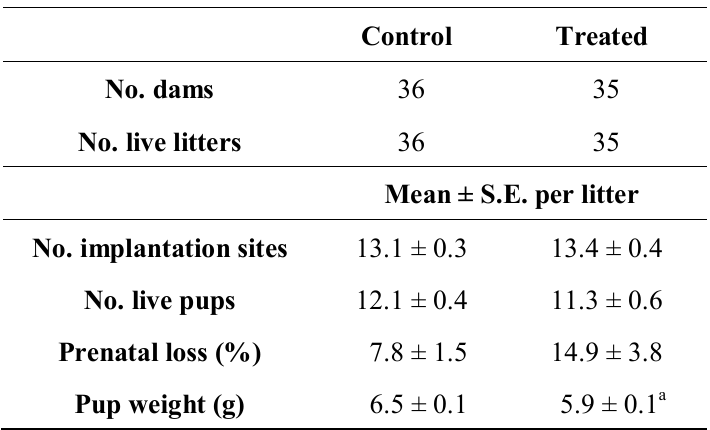
Table 1. Summary of data from pilot study with complex mixture of disinfection by-products